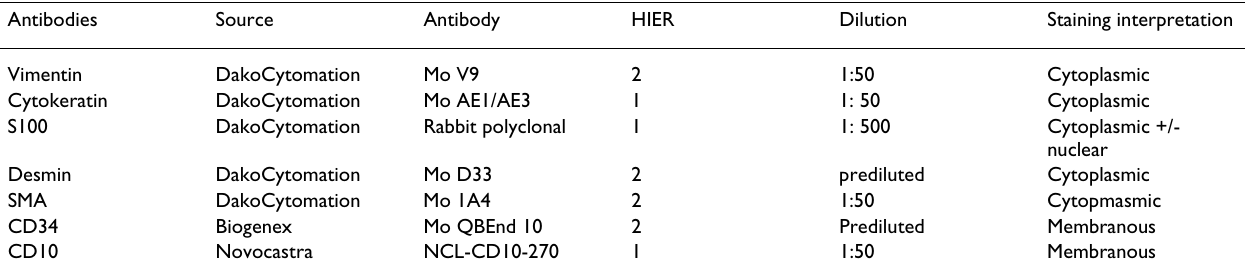
Table 1: The antibodies used in the study Antibodies Source Antibody HIER Vimentin